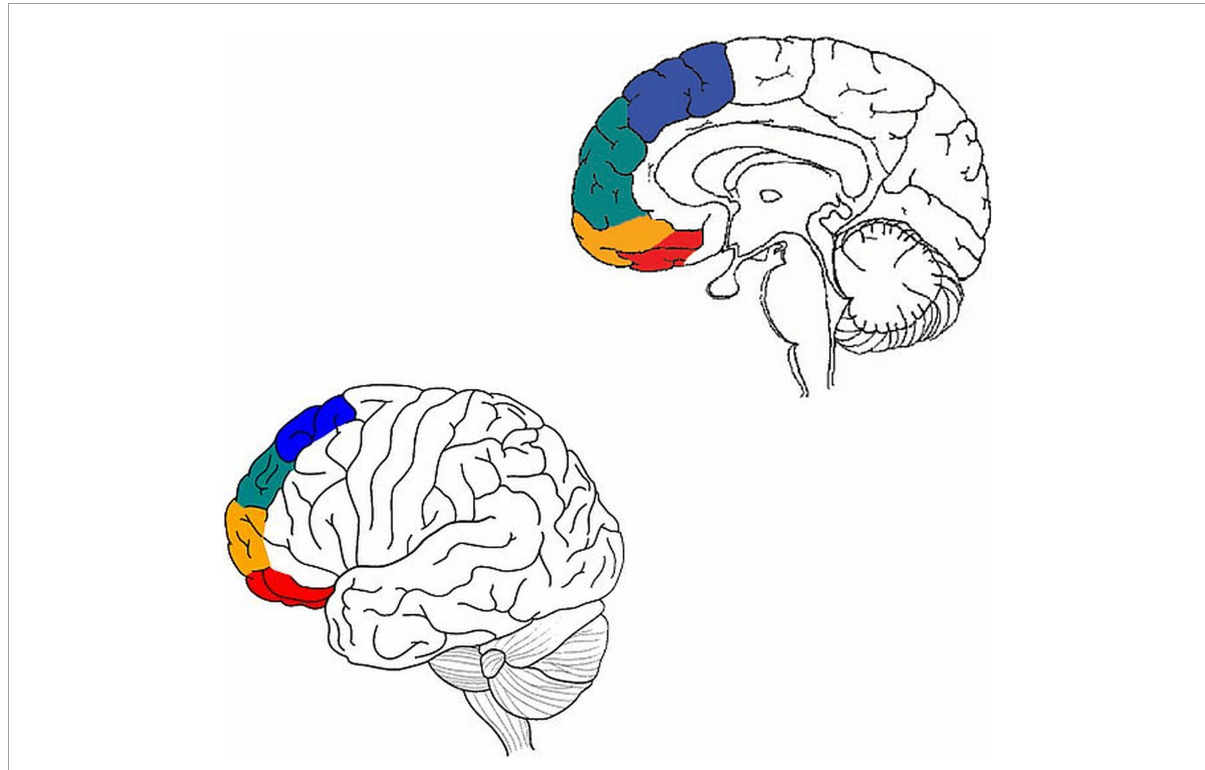
FIGURE2 Adapted from Ben Shalom (2009) and Ronel (2018). Motor processing in blue, emotion in green, memory in orange, and sensory in